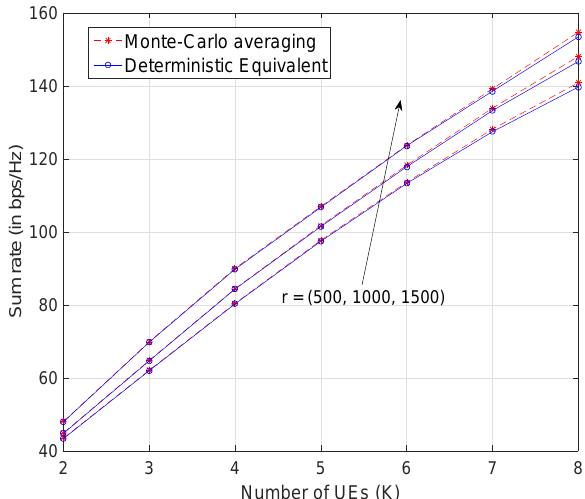
Figure 2. Comparison of ergodic sum-rate of UEs and the deterministic equivalent versus the number of